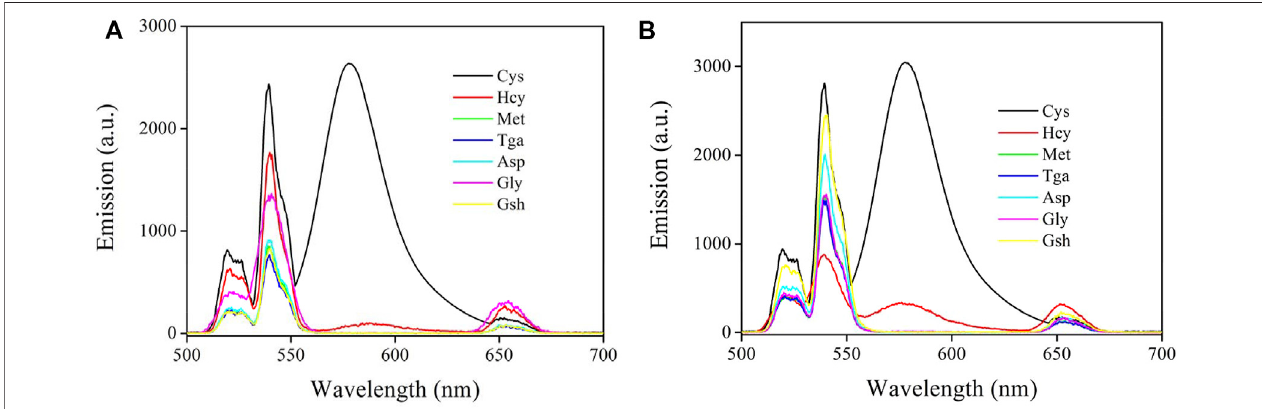
FIGURE 10 | (A) Emission spectra of Sensor-1 under Cys and several competing amino acids and thiols (20 μ M) (in PBS, pH = 7.0, 5 mg in 10 ml for host, 10 μ M for Sensor-1, λ ex = 980 nm). Homocysteine(Hcy), methionine (Met), thioglycolic acid (Tga), asparticacid (Asp), glycine (Gly), and glutathione(Gsh). (B) Emissionspectra of Sensor-2 under Cys and several competing amino acids and thiols (20 μ M) (in PBS, pH = 7.0, 5 mg in 10 ml for host, 10 μ M for Sensor-2, λ ex = 980 nm). Homocysteine (Hcy), methionine (Met), thioglycolic acid (Tga), aspartic acid (Asp), glycine (Gly), and glutathione